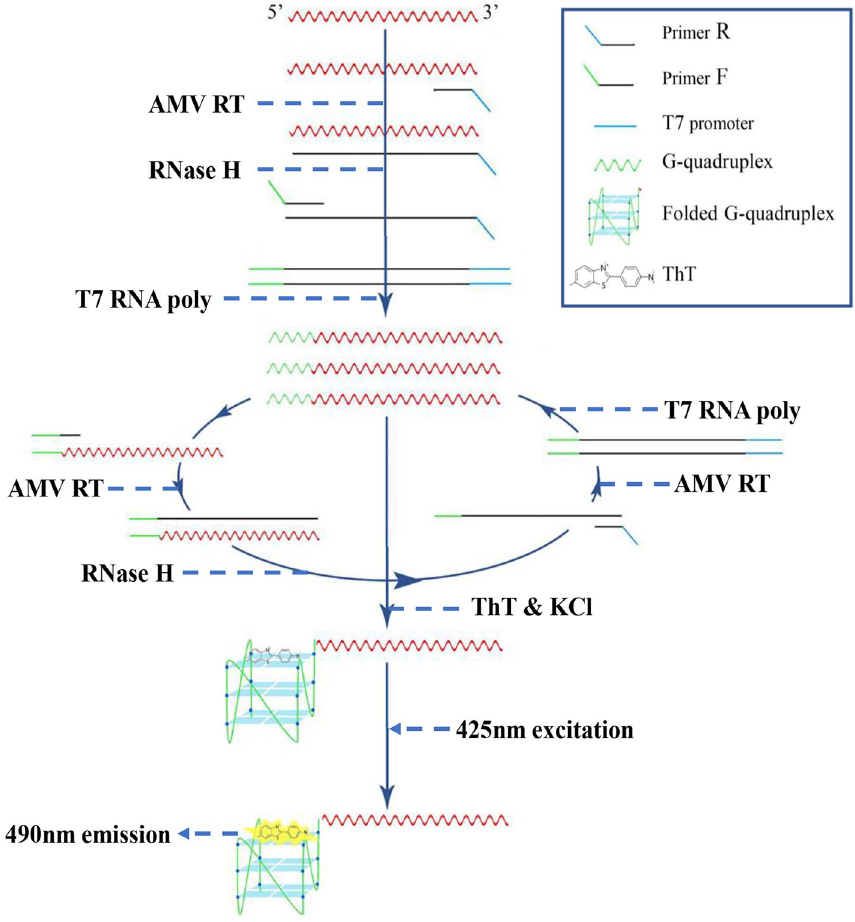
Figure 1. Principle of target RNA detection by G4-ThT-NASBA system. The G4-ThT-NASBA system features the addition of a G-quadruplex reverse complementary sequence on primer F, thereby generating an RNA product containing a G-quadruplex.These products bind to ThT with a fluorescence response detected at 425 nm excitation at 490 nm